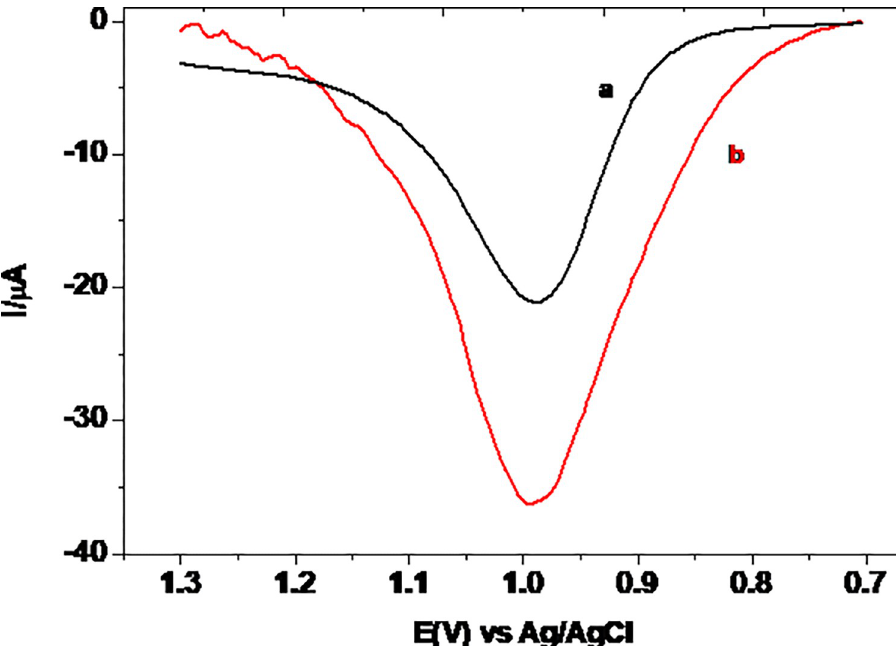
Fig 9. Corrected for blank SWVs of 0.5 mM TP in pH 7.0 PBS at UCPE (a) and MCPE (b).